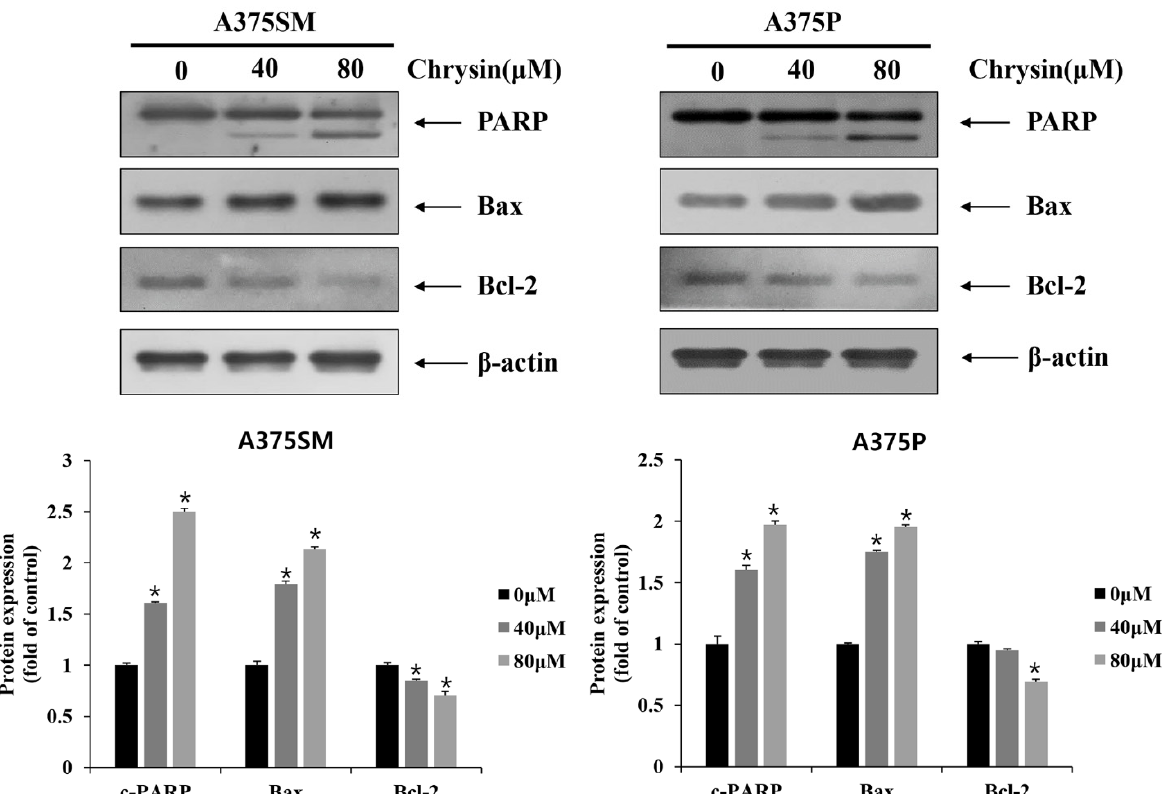
Figure 4. Chrysin induces apoptosis protein expression in A375SM and A375P human melanoma cancer cells. Cells were treated with the indicated concentrations of chrysin and the levels of poly ADP − ribose polymerase, Bax, and Bcl − 2 proteins were measured by Western blotting. β − actin was used as a loading control. Quantification was performed in three independent experiments using ImageJ, normalizing the intensities of the bands to the controls. Data are presented as the mean and standard deviation for three samples. Significance was determined by Student’s t -test, * p < 0.05, compared with the control.